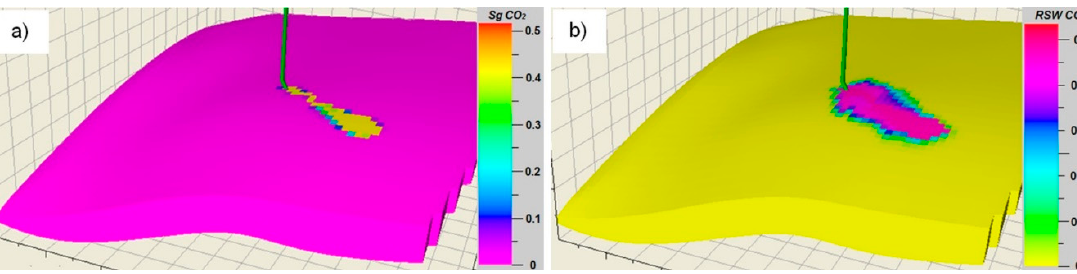
Figure 15. Changes in free CO 2 saturation—Sg ( a ) and dissolved CO 2 —RSW ( b ) in the roof part of the injection layer after 200 years from the end of injection.